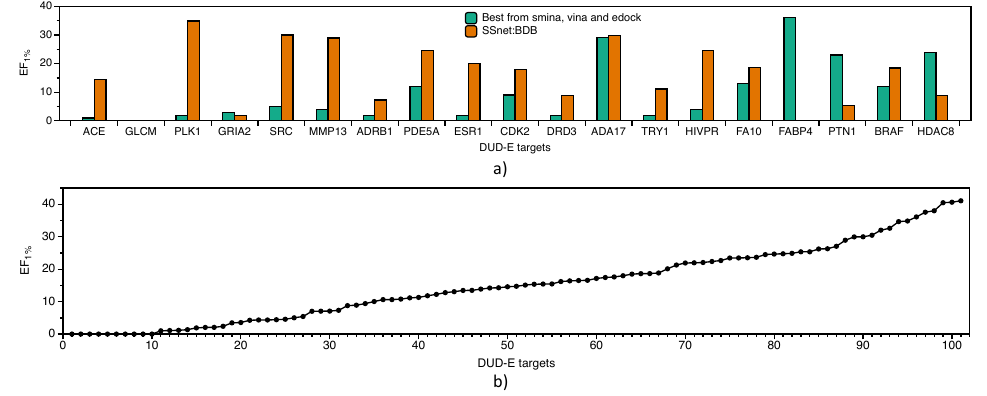
Figure 7. Independent test set DUD-E dataset for BDB model. All targets with more than 75% similarity in DUD-E dataset were removed from the BDB model. ( a ) EF 1% comparison on DUD- E targets over best performer from vina, smina, or edock; ( b ) EF 1% comparison with vina for all DUD-E